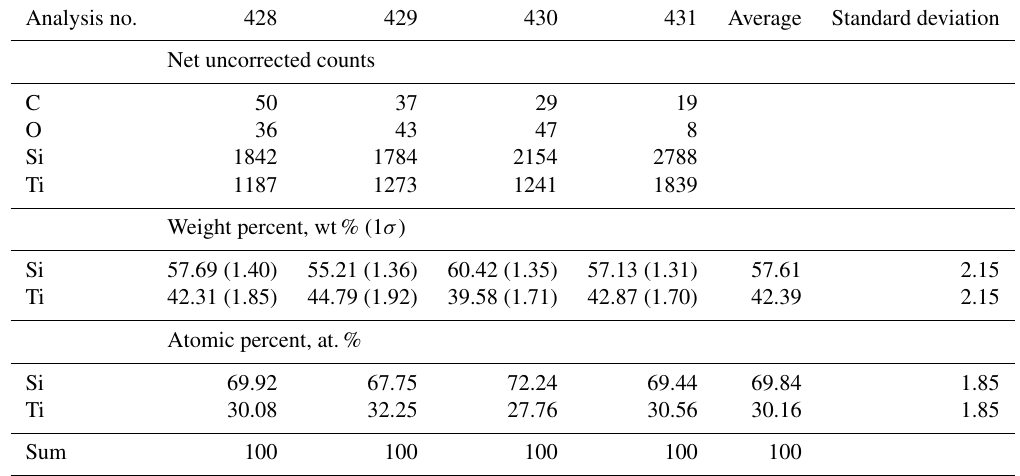
Table 3. Energy-dispersive spectroscopic (EDX) analyses of zhiqinite in foil no. 5358. Analysis no. 428 429 430 431 Average Standard deviation